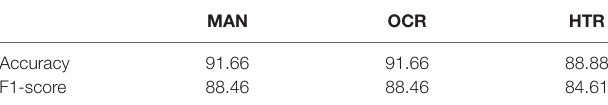
Table 7 | Leave-one-out validation results for intra-modality attribution in terms of accuracy and F1.